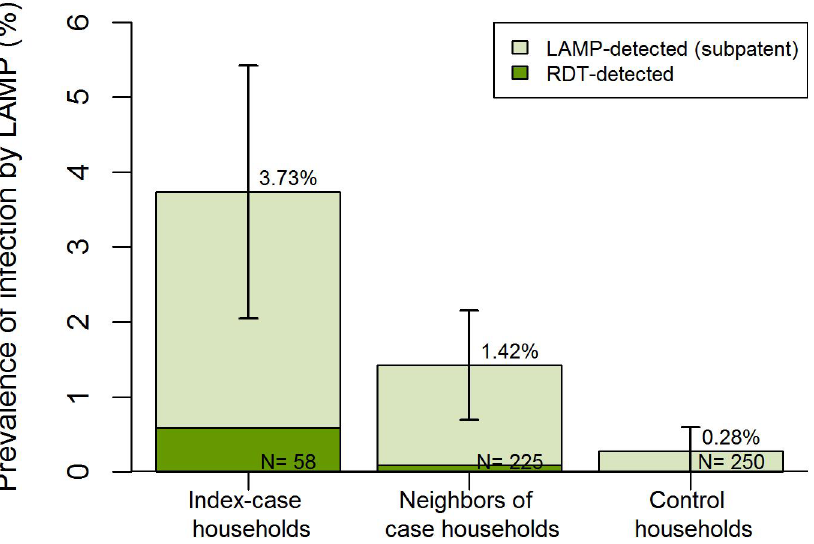
Fig 3. Clustering of patent and sub-patent secondary infections around passivelydetected index cases in Engela, compared to control